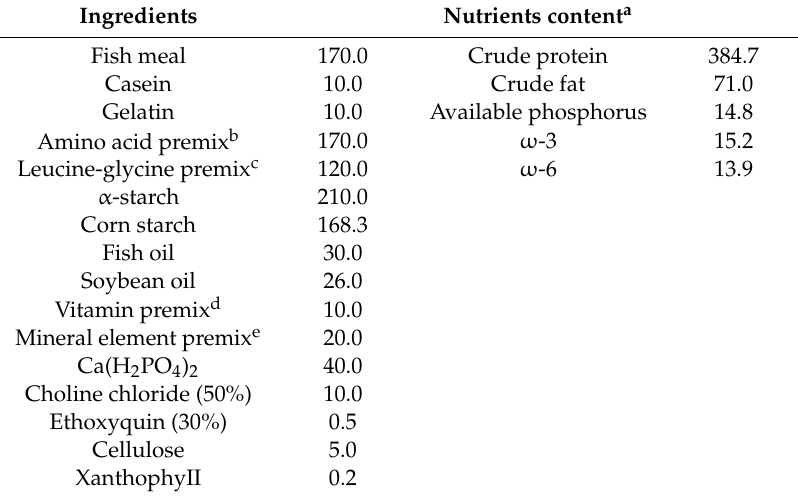
Table 1. Composition and nutrients content of basal diet (g kg − 1